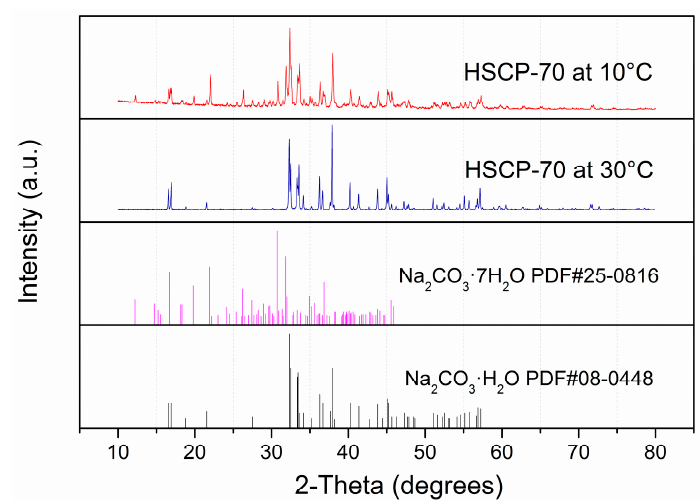
Figure 6. XRD patterns of HSCP-70 at 10 and 30 °C.